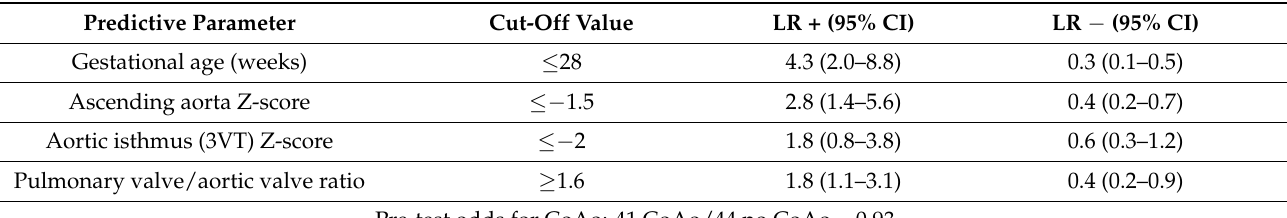
Table 1. Cut-off points and positive and negative likelihood ratios (LR+ and LR − ) of parameters of our global multiparam- eter scoring system for calculating the probability of coarctation of the aorta (CoAo) in fetuses with cardiac asymmetry, applying the formulas described in the table